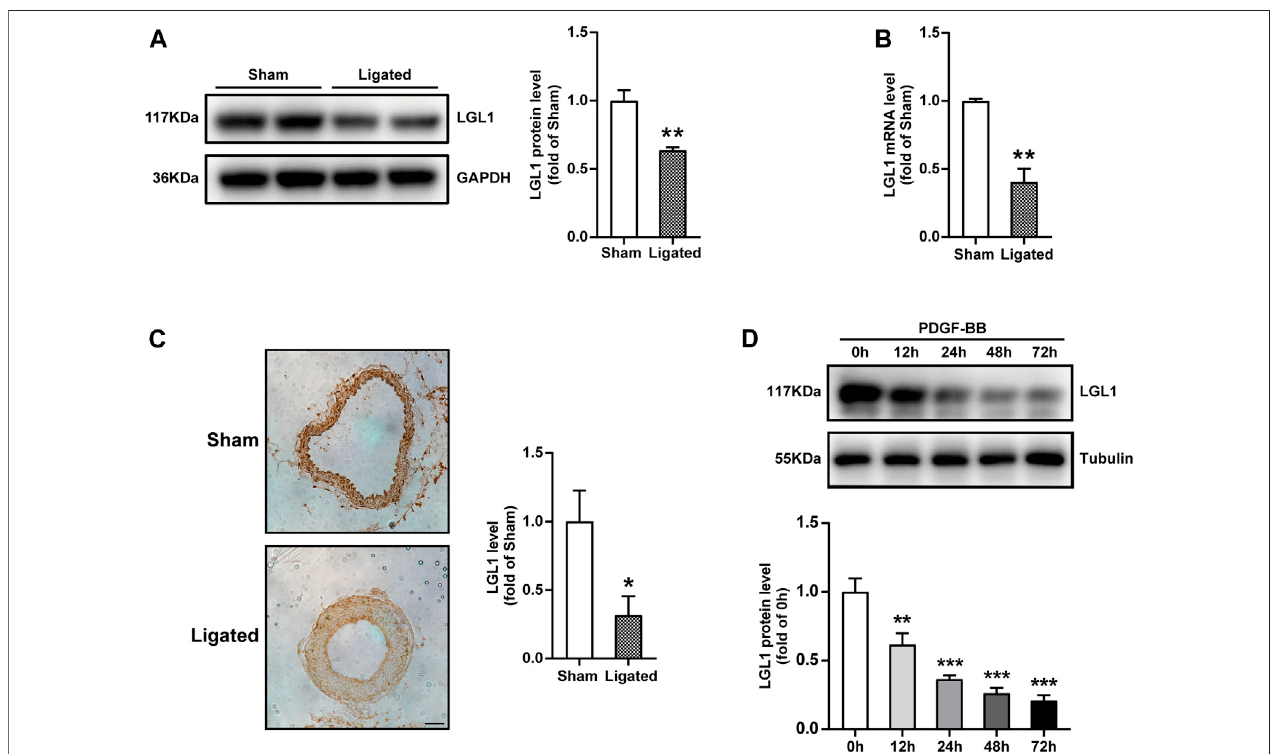
FIGURE 1 | LGL1 expression was decreased during vascular injury in mice. (A,B) Mice underwent left CCA ligation (Ligated) to induce neointimal hyperplasia; the right CCA was a control (Sham). Protein and mRNA levels of carotid artery LGL1 were tested by western blot analysis ( n = 4) (A) and qRT-PCR ( n = 5) (B) . * p < 0.05 vs. Sham. (C) The expression of LGL1 from Sham and Ligated carotid arteries detected by immunohistochemistry ( n = 4). Scale bar: 50 μ m. ** p < 0.01 vs. Sham. (D) VSMCsweretreatedwithPDGF-BB(20 ng/ml)fordifferenttimes,thenLGL1expressionwasexaminedbywesternblotanalysis( n =4).** p < 0.01,*** p < 0.001 vs. PDGF-BB 0